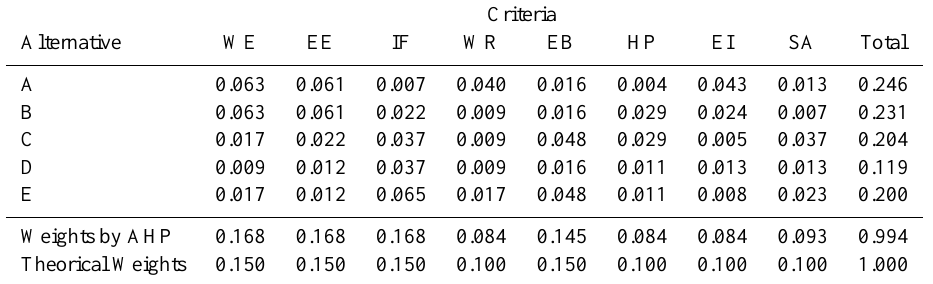
Fig. 7. Graph of Expert Choice AHP application to sub zone La Estrella. Table 4. Application of AHP method to select alternatives to desertification control for La Estrella sub zone in Salta Province (Argentina).